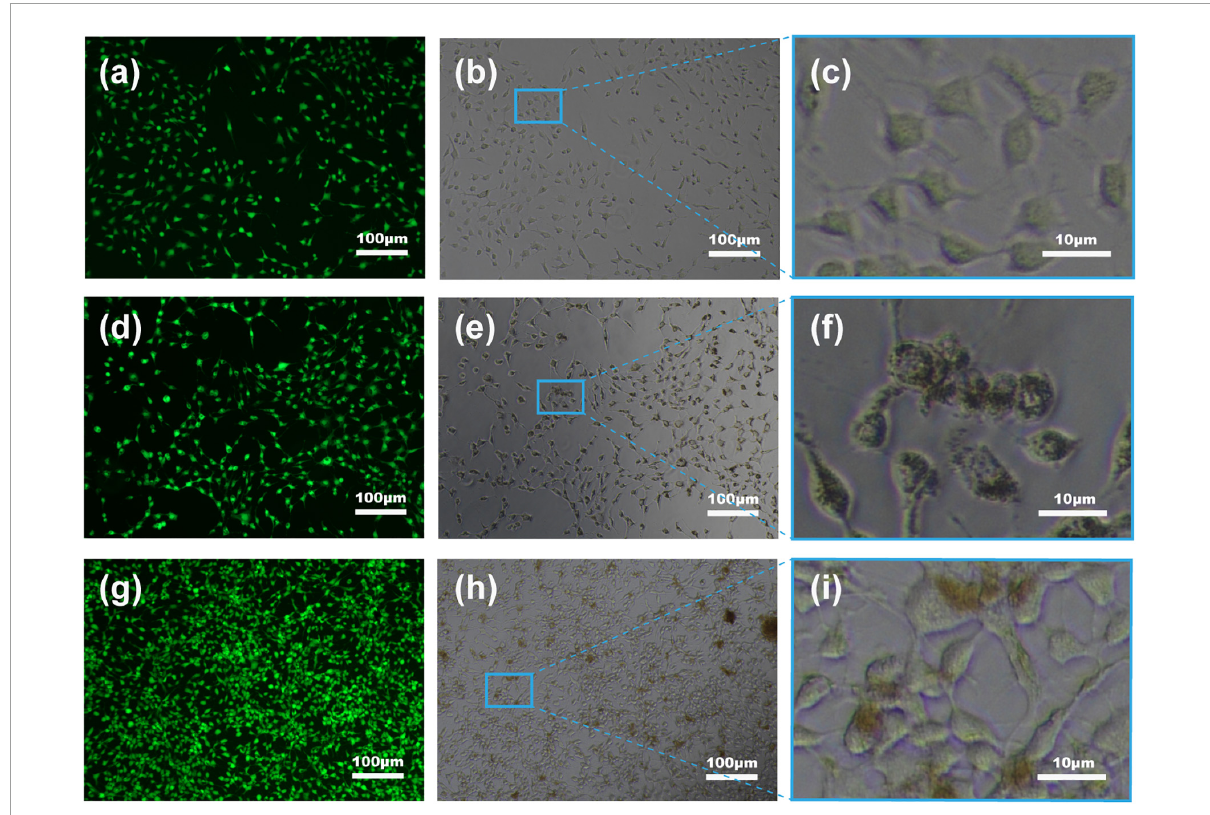
FIGURE8 Fluorescent images of SKOV-3 cells following staining with calcein AM. (a–c) NC, (d–f) Fe 3 O 4 nanoparticles, and (g–i) CS-Fe 3 O 4 nanoparticles at pH 7 after 24 h after